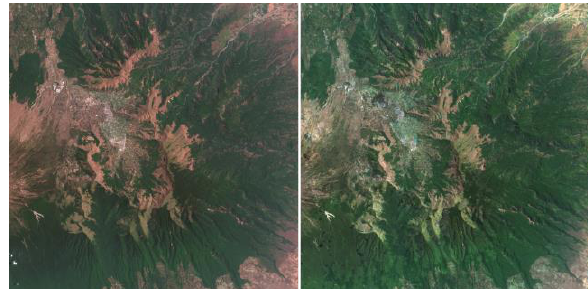
Figure 15. Squared sample of 20 km along the Post-disaster image scene. (Left) Original image taken at October 10, 2018; (Right) Cloudless image obtained by means of the M2CTool Scatterplots of reflectance values (band-by-band) among the reconstructed cloudless image, in comparison with an uncontaminated squared sample of the Sentinel-2 image, is also provided, for the image taken at October 10, 2018, as provided in Figure 16.